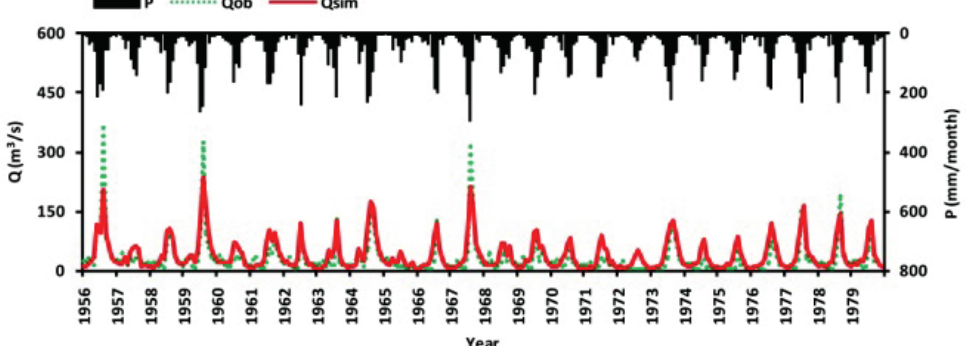
Fig. 2 The simulated and observed monthly average discharge of Xiaojue from 1956 to